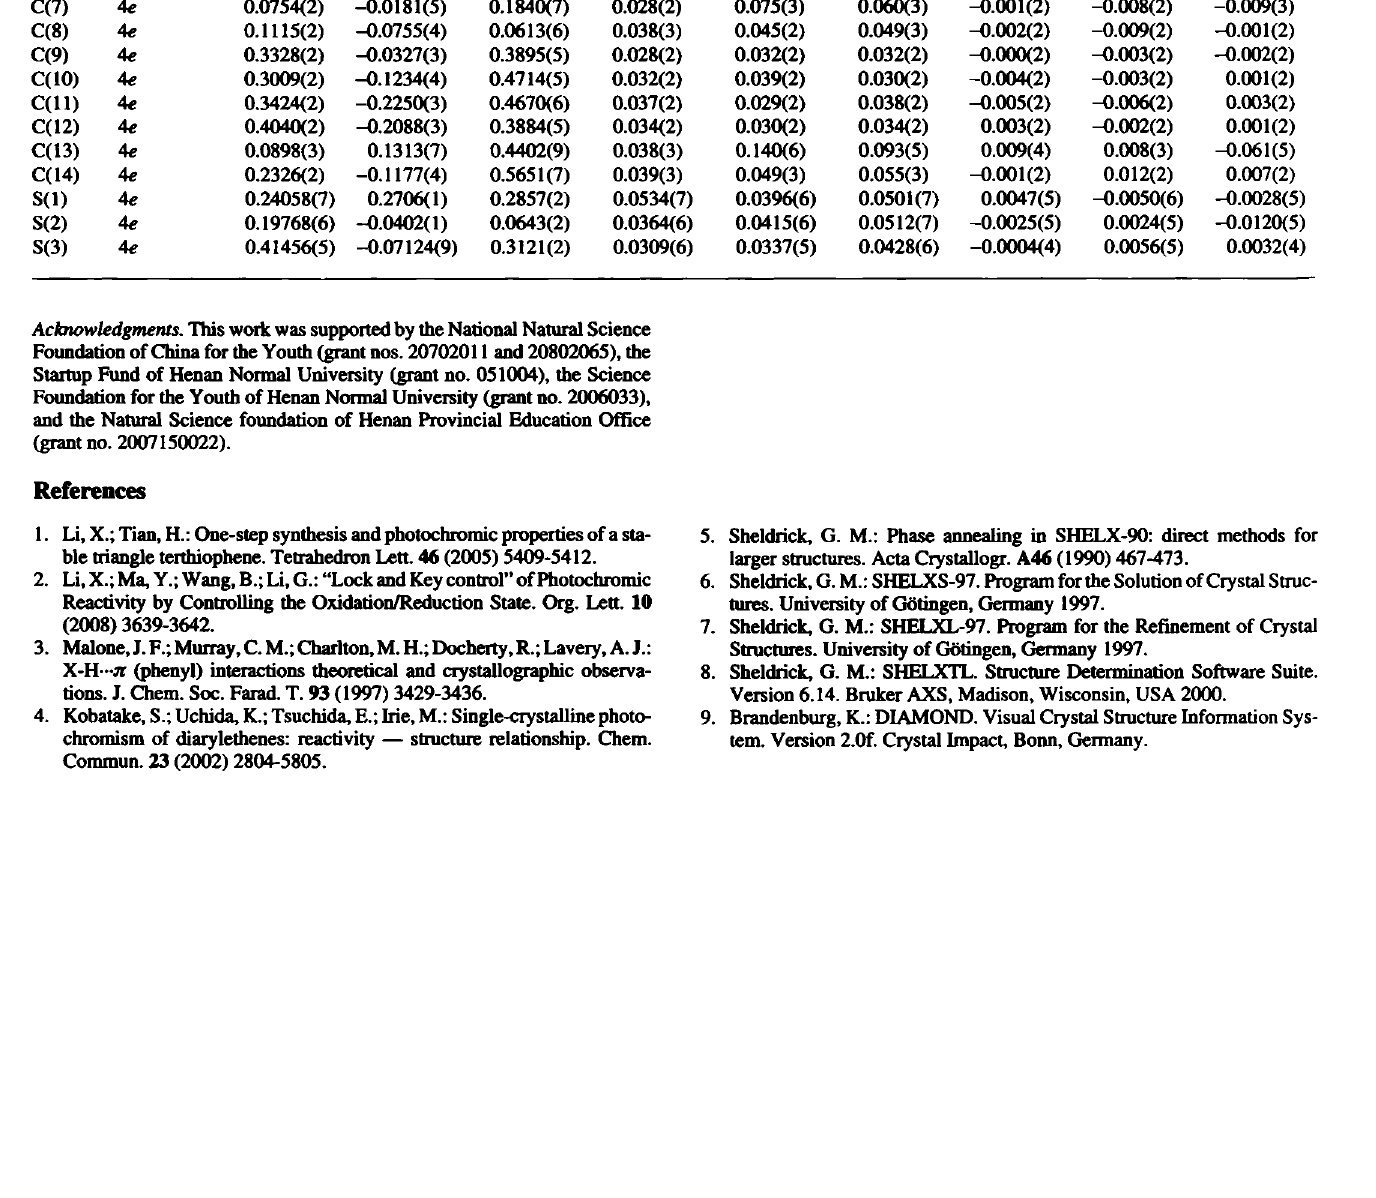
Table 3. Atomic coordinates and displacement parameters (in Â 2